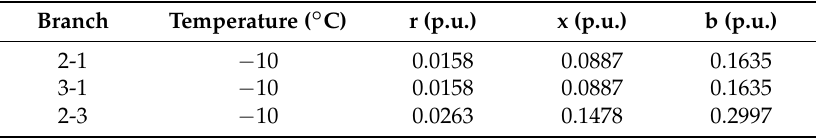
Table 5. The impedance and susceptance when the conductor temperature is − 10 ◦